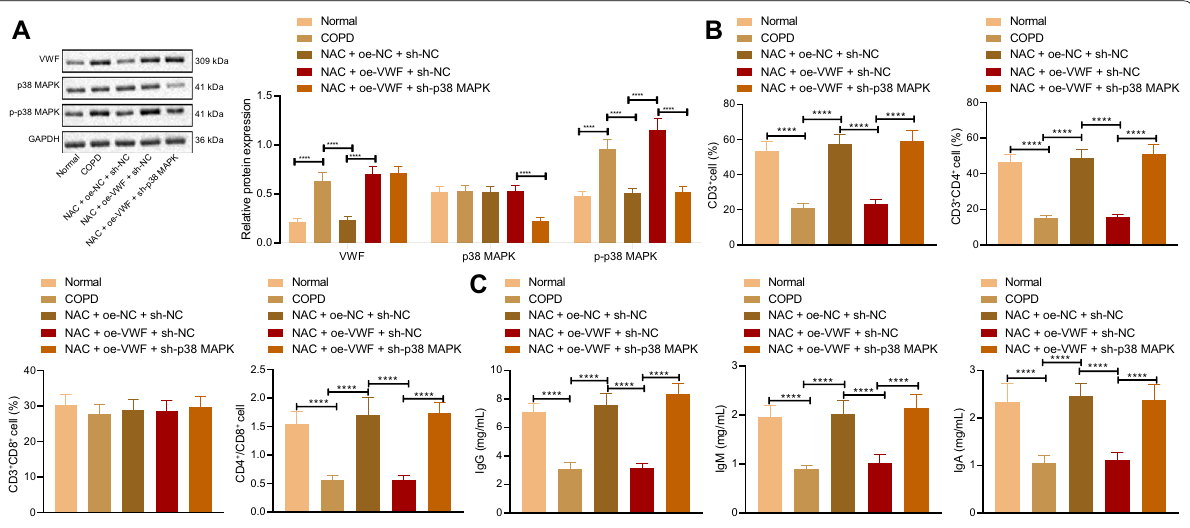
Fig. 6 NAC affects the immune response in vivo through the VWF/p38 MAPK axis. COPD rats were treated with NAC and oe-VWF and/or sh-p38 MAPK (n 10). A Expression of VWF and p38 MAPK, and the extent of p38 MAPK phosphorylation in lung tissues of COPD rats determined by = Western blot analysis. B The ratio of CD3 + , CD4 + , CD8 + and CD4 + /CD8 + T lymphocytes in serum of COPD rats measured by flow cytometry. C Levels of IgG, IgA, and IgM in serum of COPD rats measured by ELISA. **** p < 0.0001. Data are shown as the mean replicates. Data among multiple groups were compared by one-way ANOVA with Tukey’s post hoc